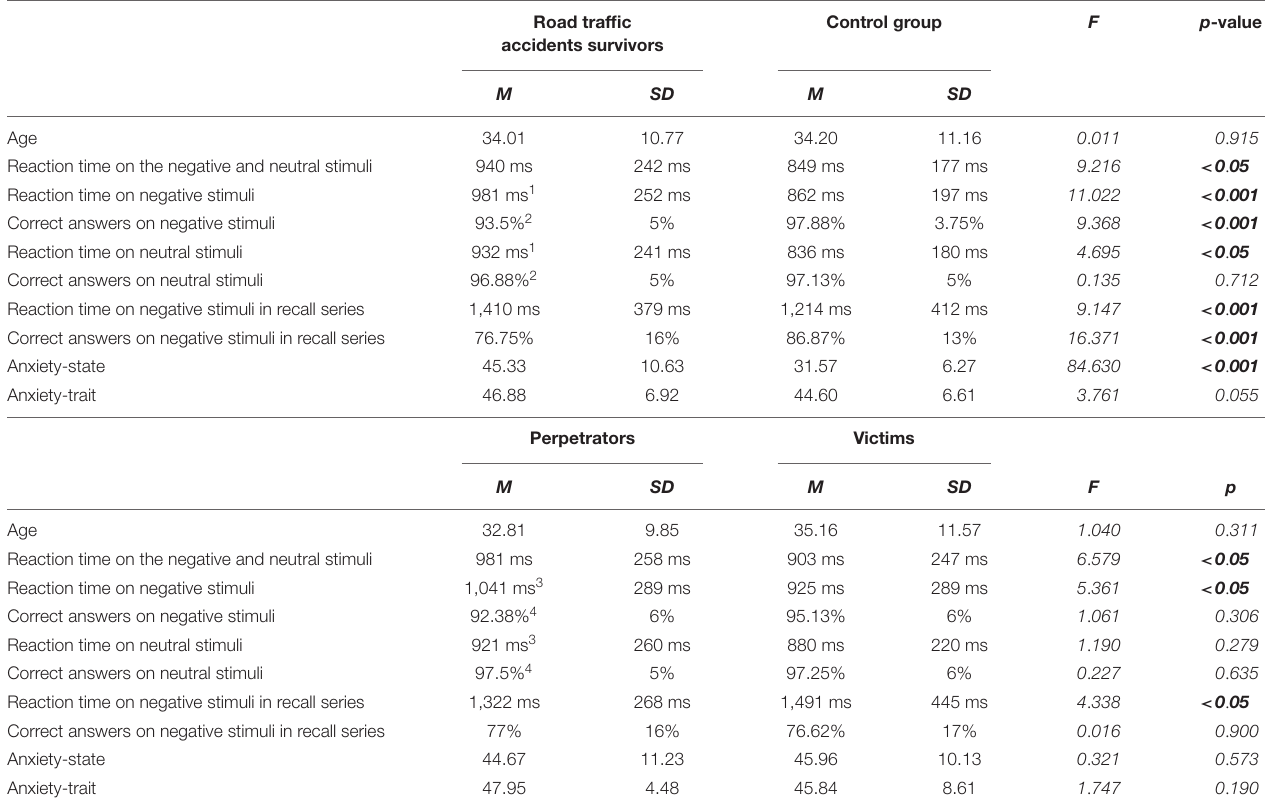
TABLE 1 | Descriptive statistics and intragroup, intergroup